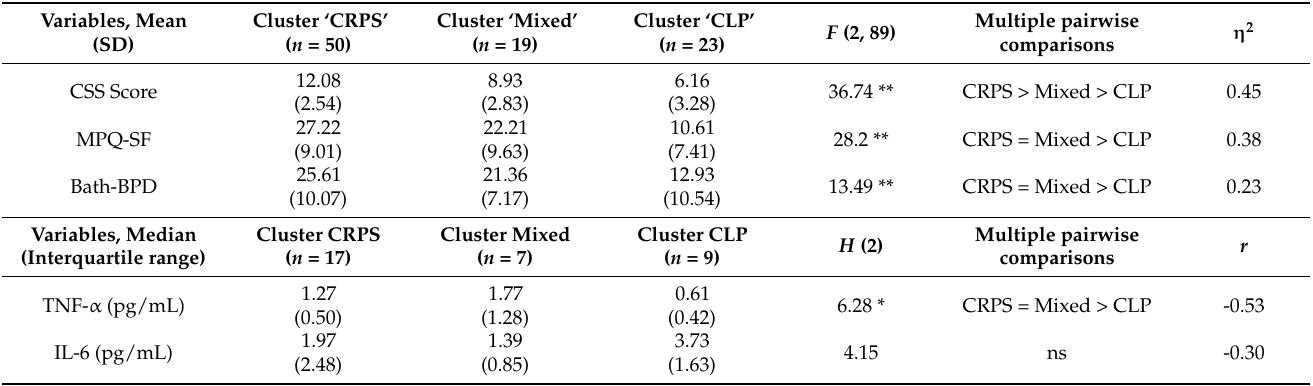
Table 4. Cluster group differences in CSS, MPQ-SF, Bath-BPD scores and pro-inflammatory